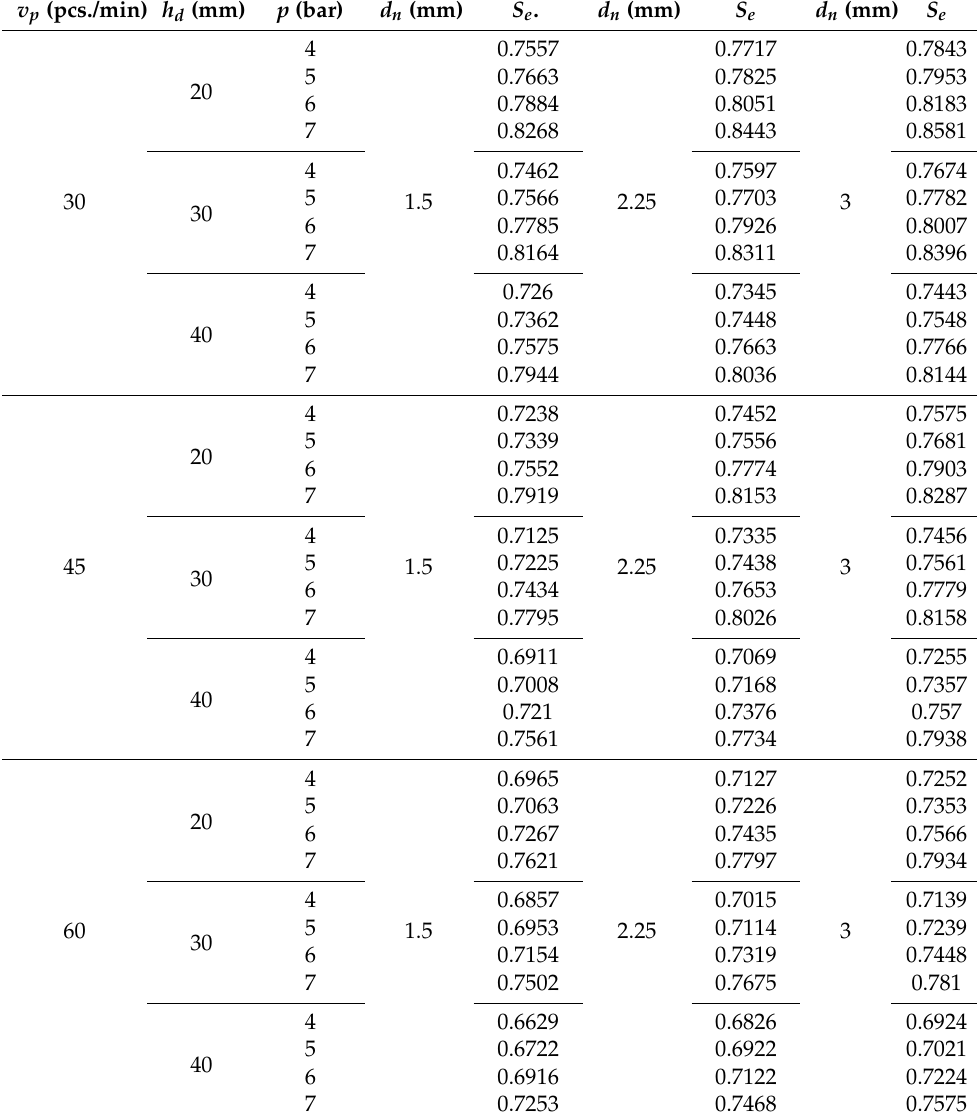
Table 3. Experimental tests results for n d = 3